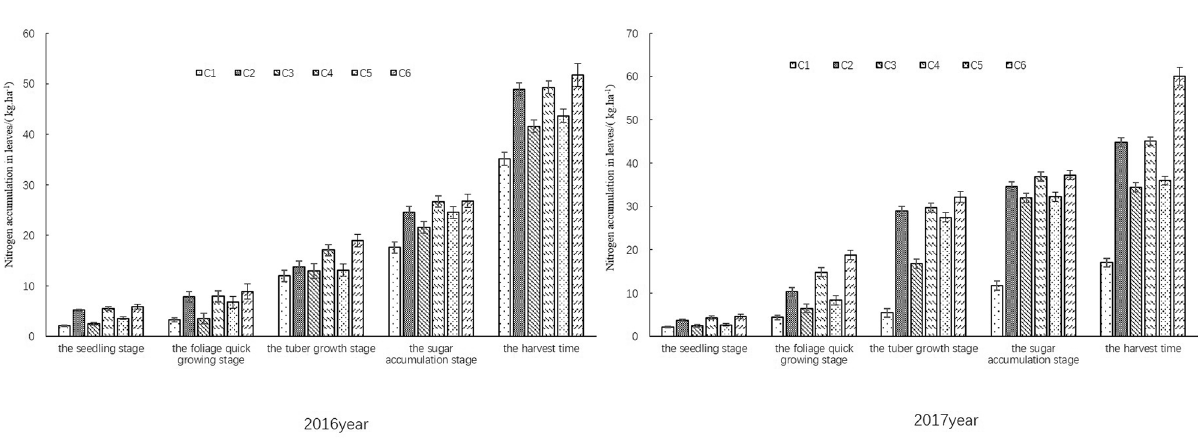
Figure 6. Effect of limited irrigation on nitrogen accumulation rate in the leaves of sugar beet in 2016 and